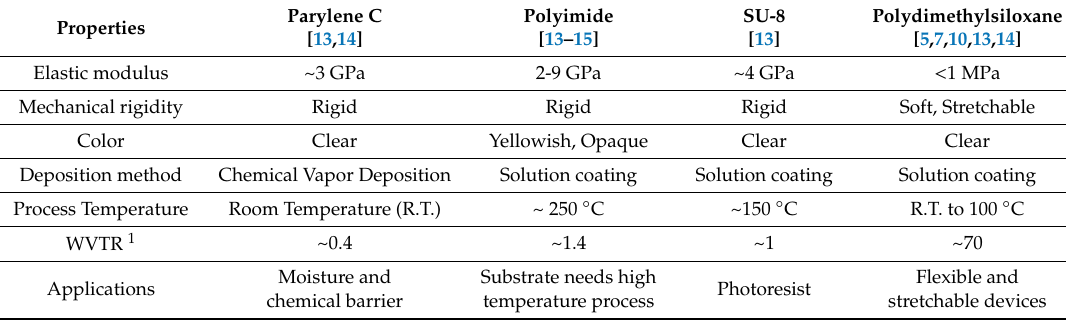
Table 1. Material properties of various biocompatible